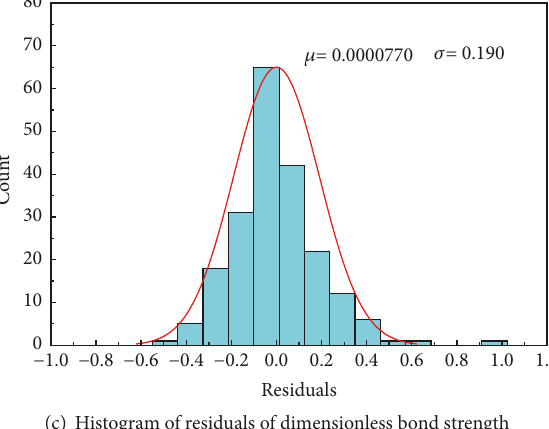
Figure 5: Dimensionless bond strength of pull-out specimens with deformed rebar (stirrups): (a) dimensionless bond strength versus corrosion level; (b) residuals versus corrosion level; (c) histogram of residuals of dimensionless bond